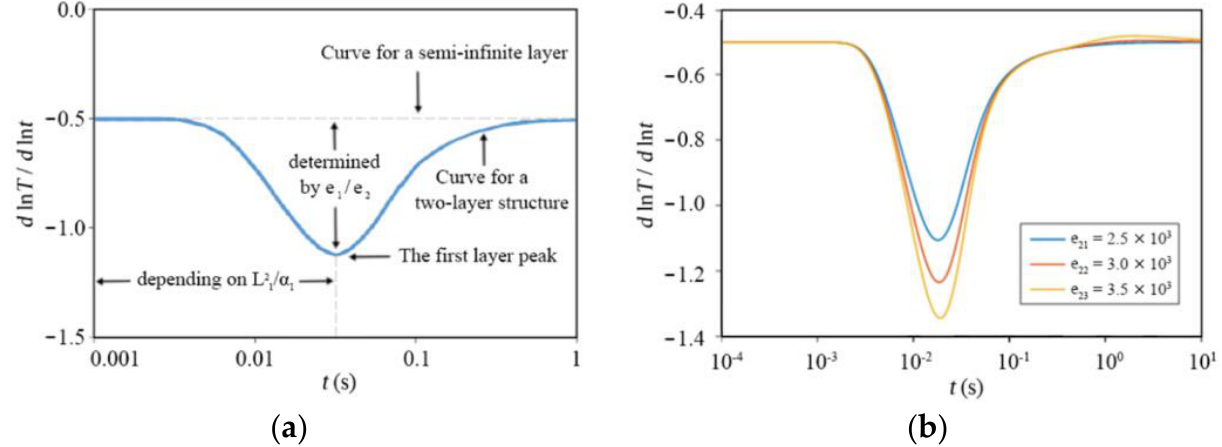
Figure 7. Illustration of the logarithmic 1st derivative of surface temperature ( a ) for a two-layer material with a semi-infinite second layer under instantaneous surface heating, and ( b ) for the second layer with a different thermal effusivity.